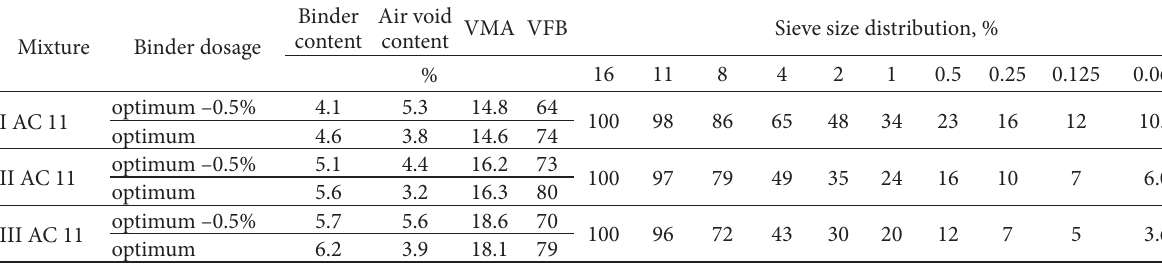
Table 1. AC 11 mixture design evaluation Mixture